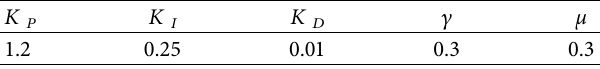
Figure 9: Te overall closed-loop control scheme of the PMSG based WECS. Table 6: Fixed parameters of the FFOPID